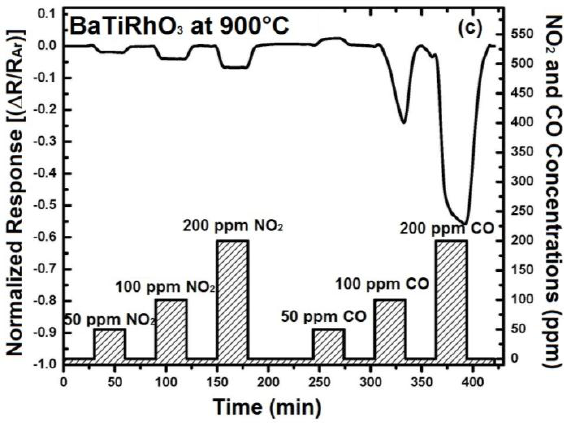
Figure 8. Sensor response of the BaTi 0.95 Rh 0.05 O 3 catalyst layer towards NO 2 and CO at 600 ˝ C ( a ) 800 ˝ C ( b ), and at 900 ˝ C ( c ) in dry argon.